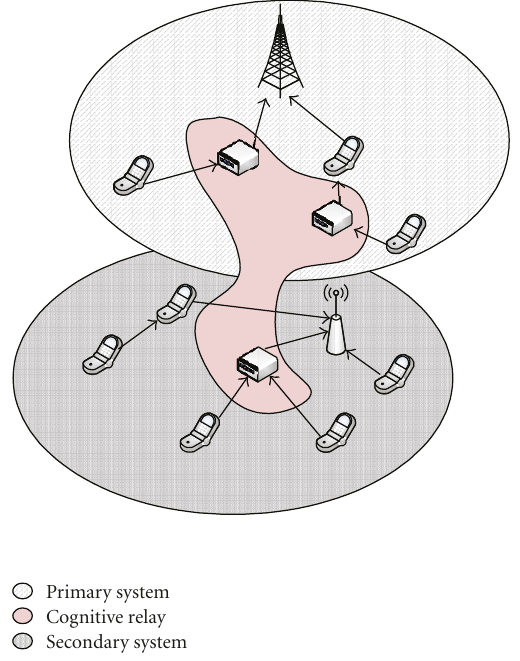
Figure 1: A cost-e ff ective spectrum sharing